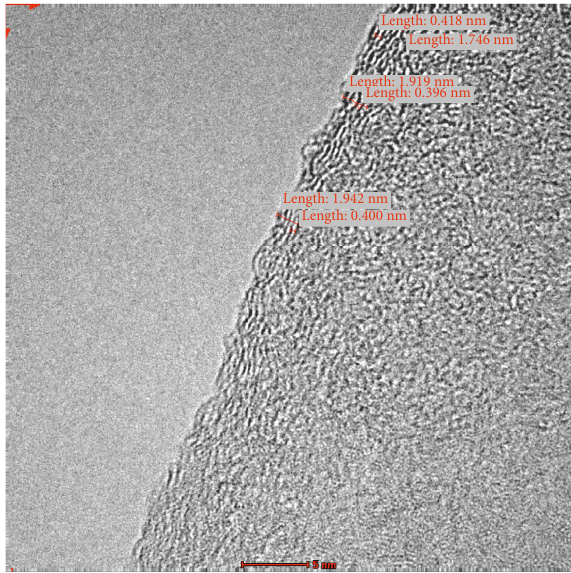
Figure 4: HRTEM image of graphene nanoplatelets viewed at 1,000,000 magnification.